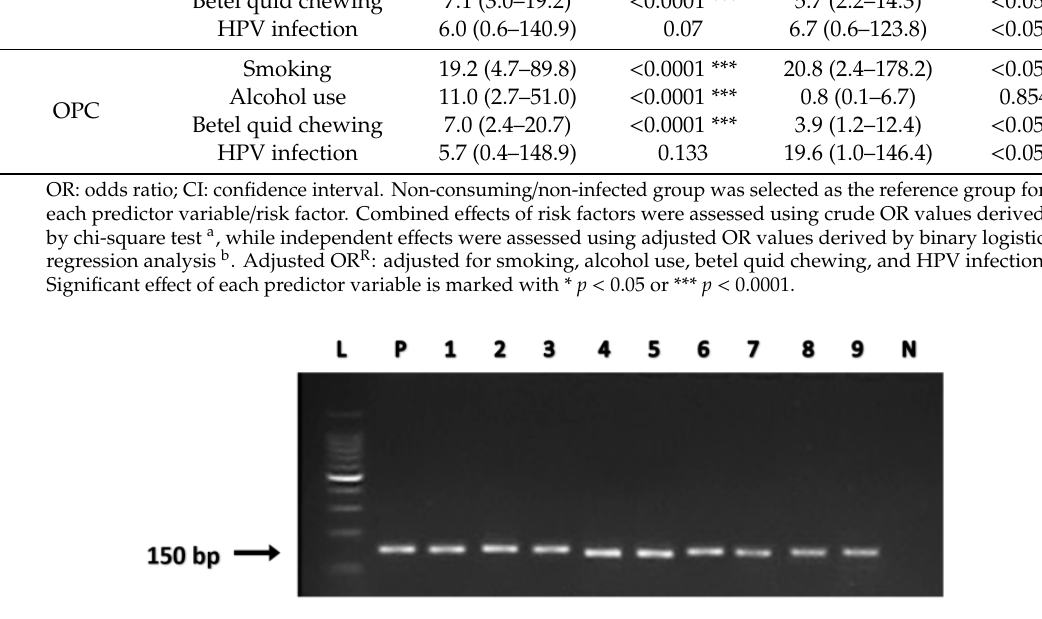
Figure 1. Agarose gel electrophoresis of HPV-L1 analysis. L: 100-bp DNA ladder with 500-bp marker; P: positive control; N: negative PCR control. Samples 1–5: oral cancer (OC) patient samples; Samples 6–8: oropharyngeal cancer (OPC) patient samples; Sample 9: healthy control sample.